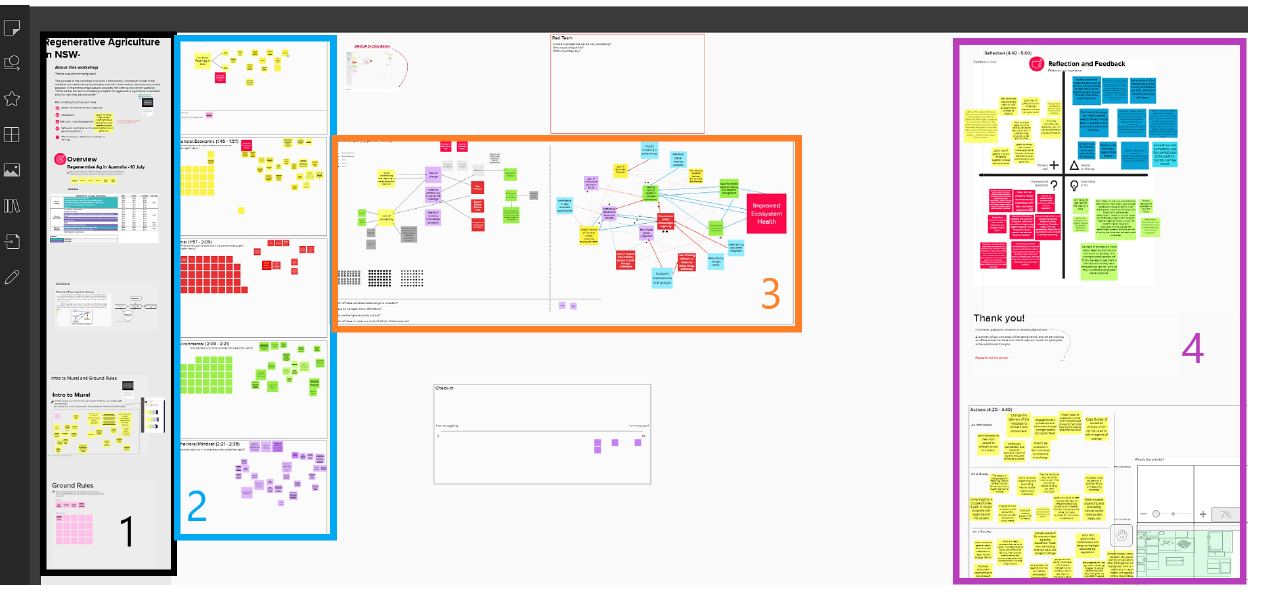
Figure 2. A screenshot of the structure we created on MURAL for each of the four stages of the workshop: (1) plenary, (2) elicitation, (3) modelling, and (4)